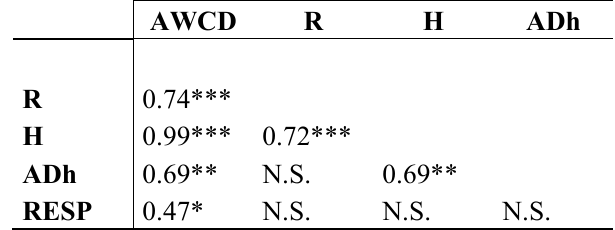
Table 5. Correlation coefficients (r) between examined microbial